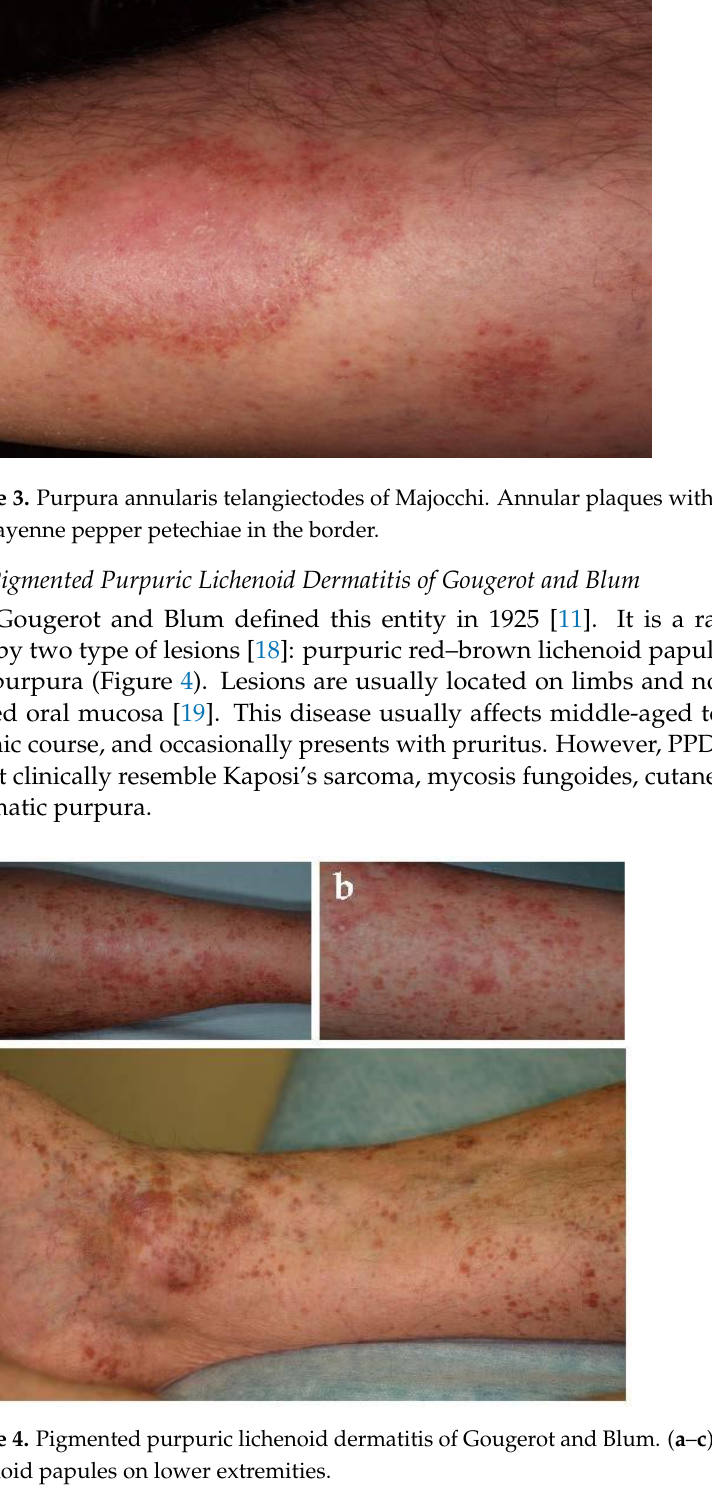
Figure 5. Lichen aureus. ( a ) Symmetrical and bilateral yellow-brown patches involving two malle- oli. ( b ) Single localization of a rust-color patch on the first phalanx of the third finger. ( c ) Lichen aureus on the legs.